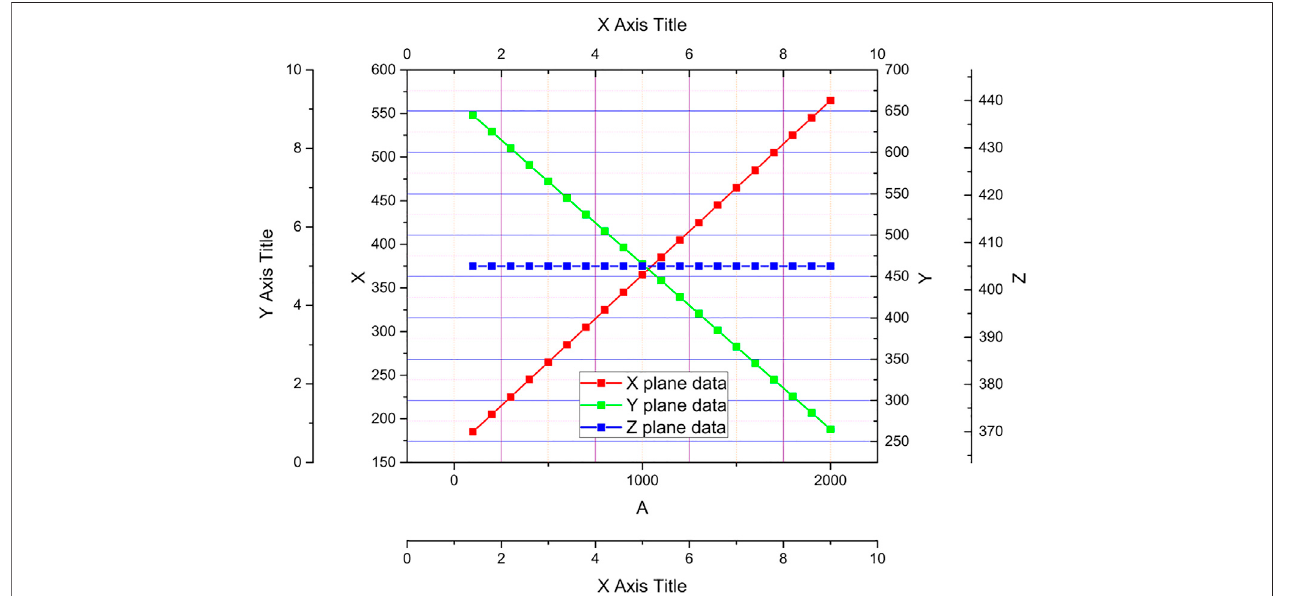
FIGURE 3 | Fading point to determine the initial point of the target plane schematic.